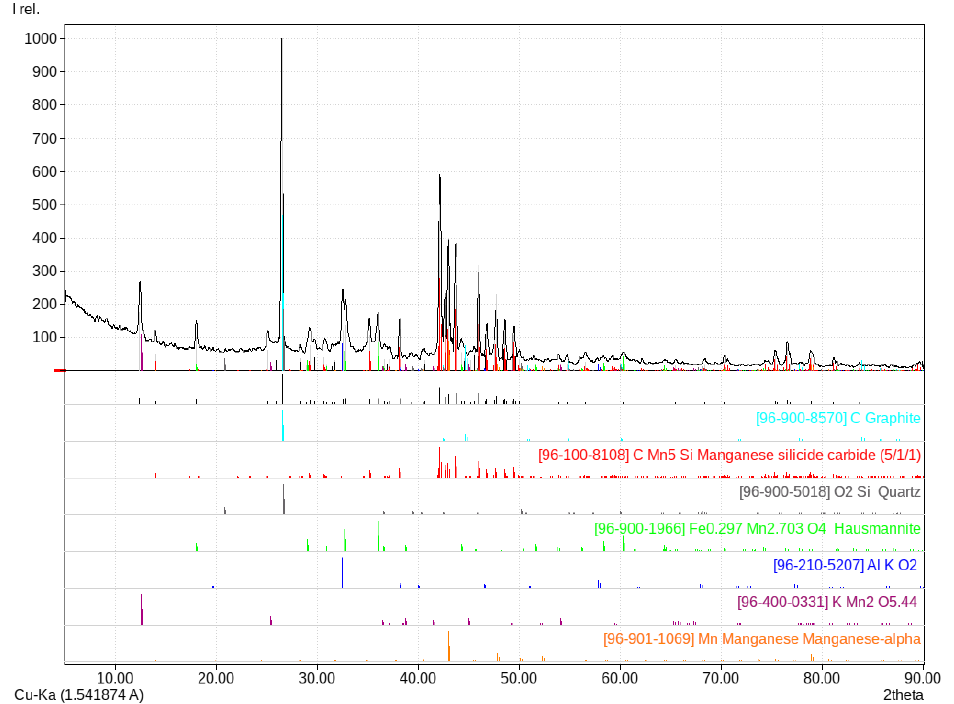
Figure 10. XRD pattern of FD13 briquette after TGA-MS test.